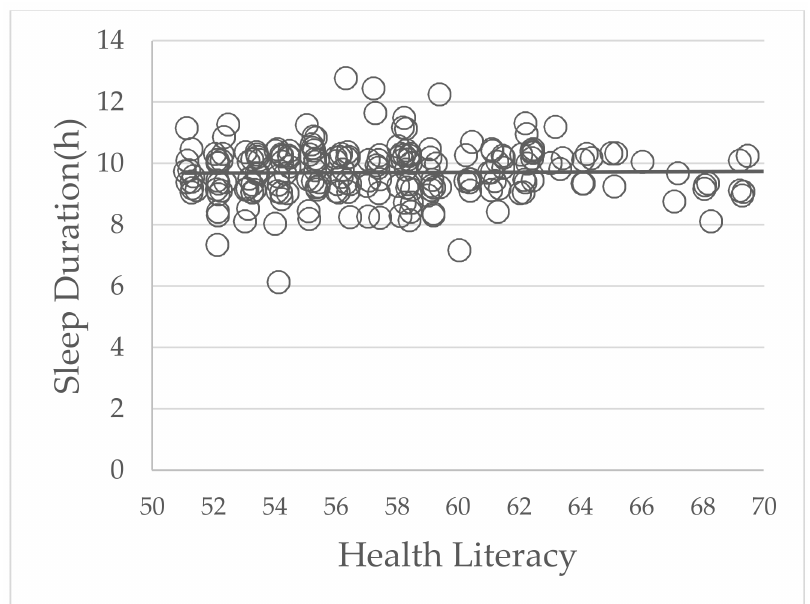
Figure 3. The correlation between parents’ health literacy and their children’s sleep duration in the high health literacy group. The p value was 0.98 and the correlation coefficient (r) was